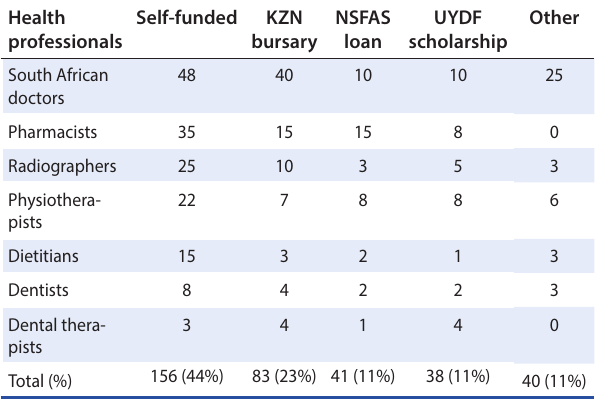
Table 3: Funding sources of the health professionals ( n = 358)